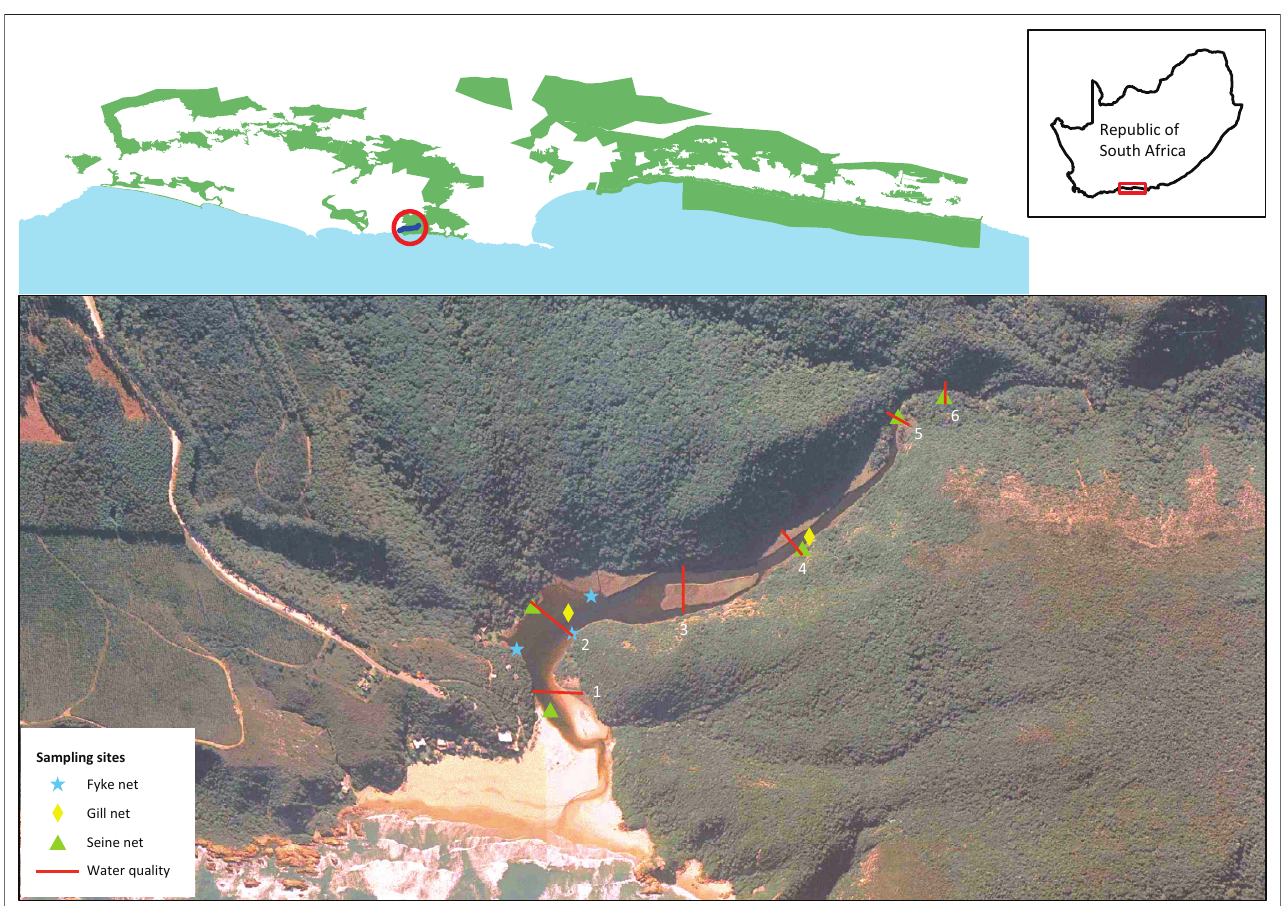
FIGURE 1: Map of the Noetsie Estuary in relation to the Garden Route National Park and placement of sampling